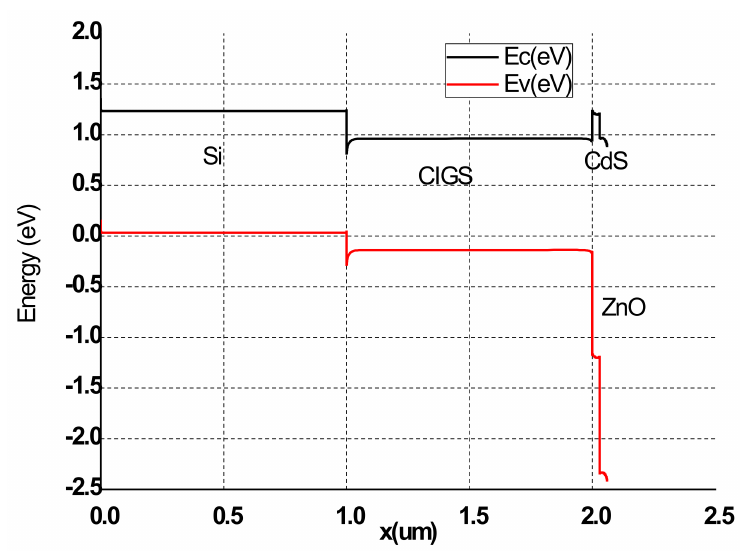
Figure 3. Band diagram for CIGS structure solar cells with